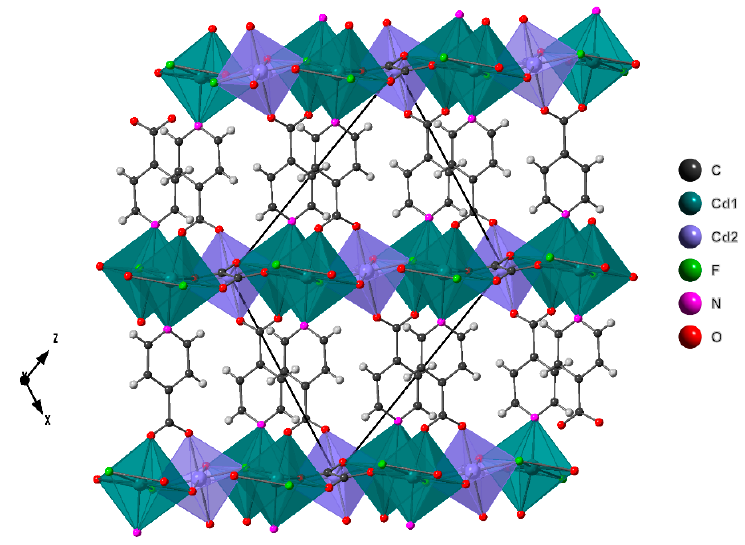
Figure 1. Crystal structure representation of compound 1 .